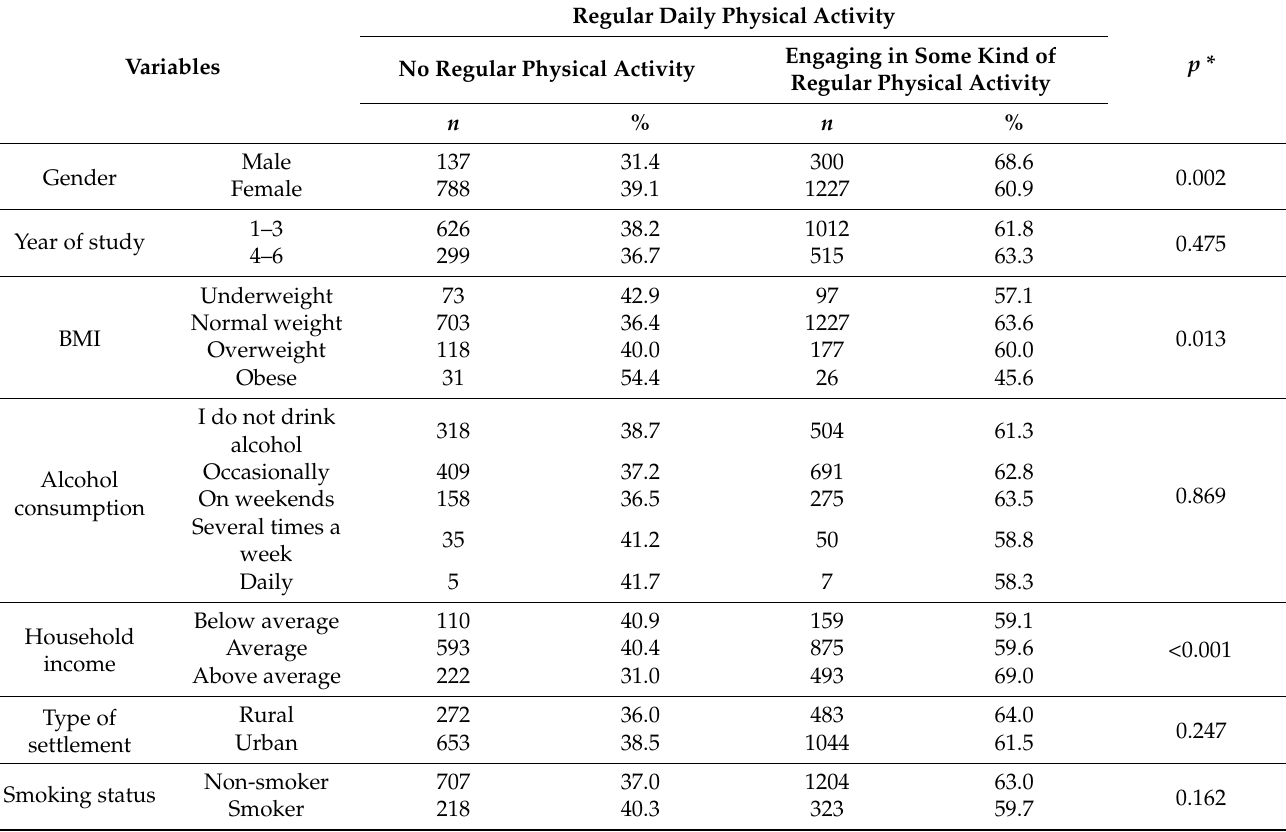
Table 3. Regular daily physical activity of medical students, in relation to the independent